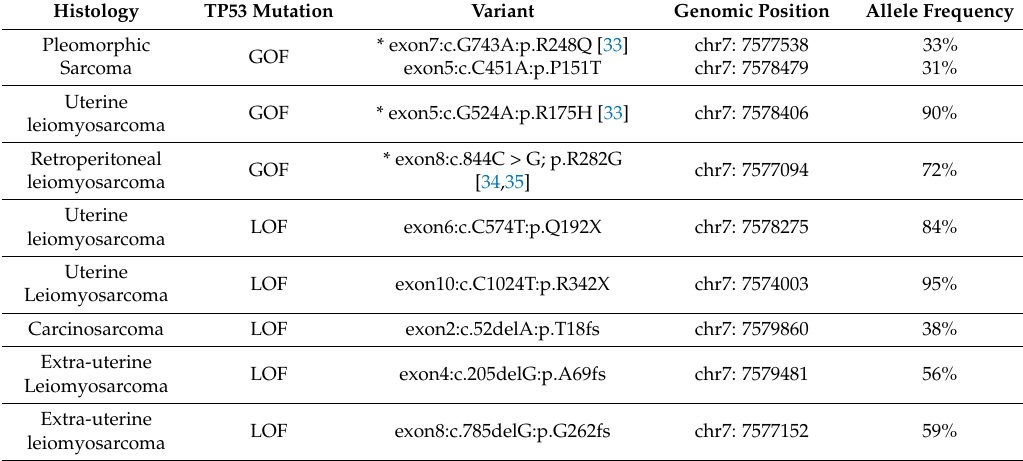
Table 4. Types of TP53 mutations in different histologic subtypes of soft tissue sarcomas with their respective position and allele frequencies. * represents likely gain of function mutations Histology TP53 Mutation